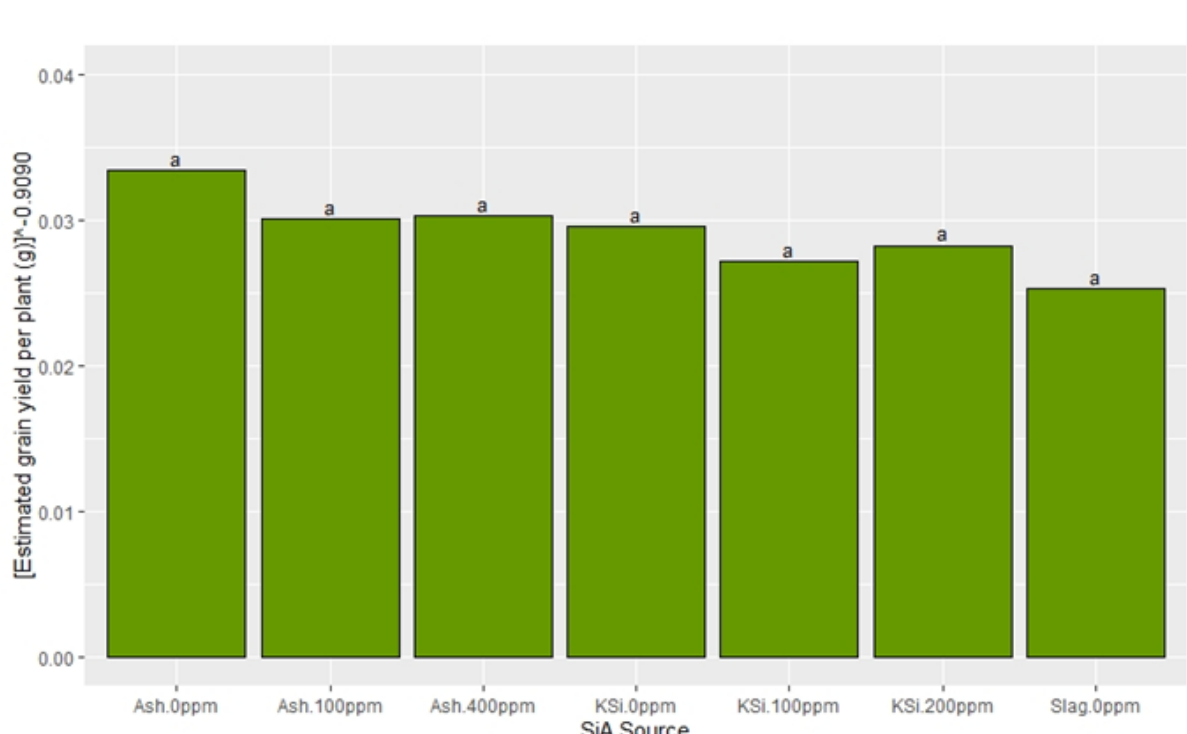
] -0.9090 . Significance levels were obtained with Tukey (g)